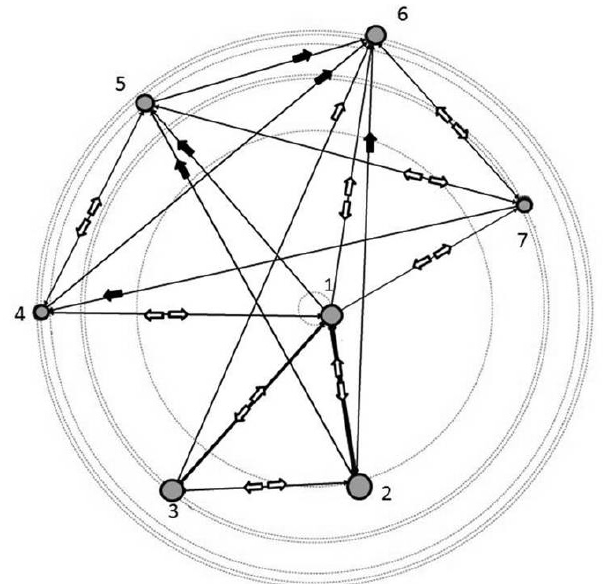
Fig 4. Results of the network analysis for seven females tracked in the second generation of Euglossa annectans . In the graph of the network, a link between two nodes (two females) reports the interaction. The arrows (black) departing from one node ( e.g. female “1”) to another node (female “5”) indicate the direction of an interaction, i.e. female “1” attacking female “2”. The absence of an arrow from one node to another node or a complete absence of a link indicates absence of an attack or an interaction, respectively. If two individuals exchange mutual attacks, two arrows (white) in opposite directions are attached to the link. The thickness of the link (an interaction) indicates how many interactions between two given nestmates were observed, and the size of the node indicates how much a given bee was attacked. Thus, bigger nodes indicate a given female that received a greater number of attacks. Thus the most central bee (female “1”) was interacting more than others and also more frequently initiated an aggressive event. Every individual has a concentric circle showing the spatial place of each individual in the network.